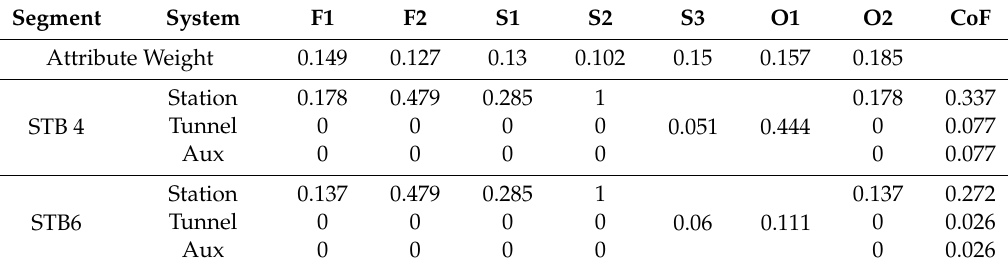
Table 8. Failure impacts Module